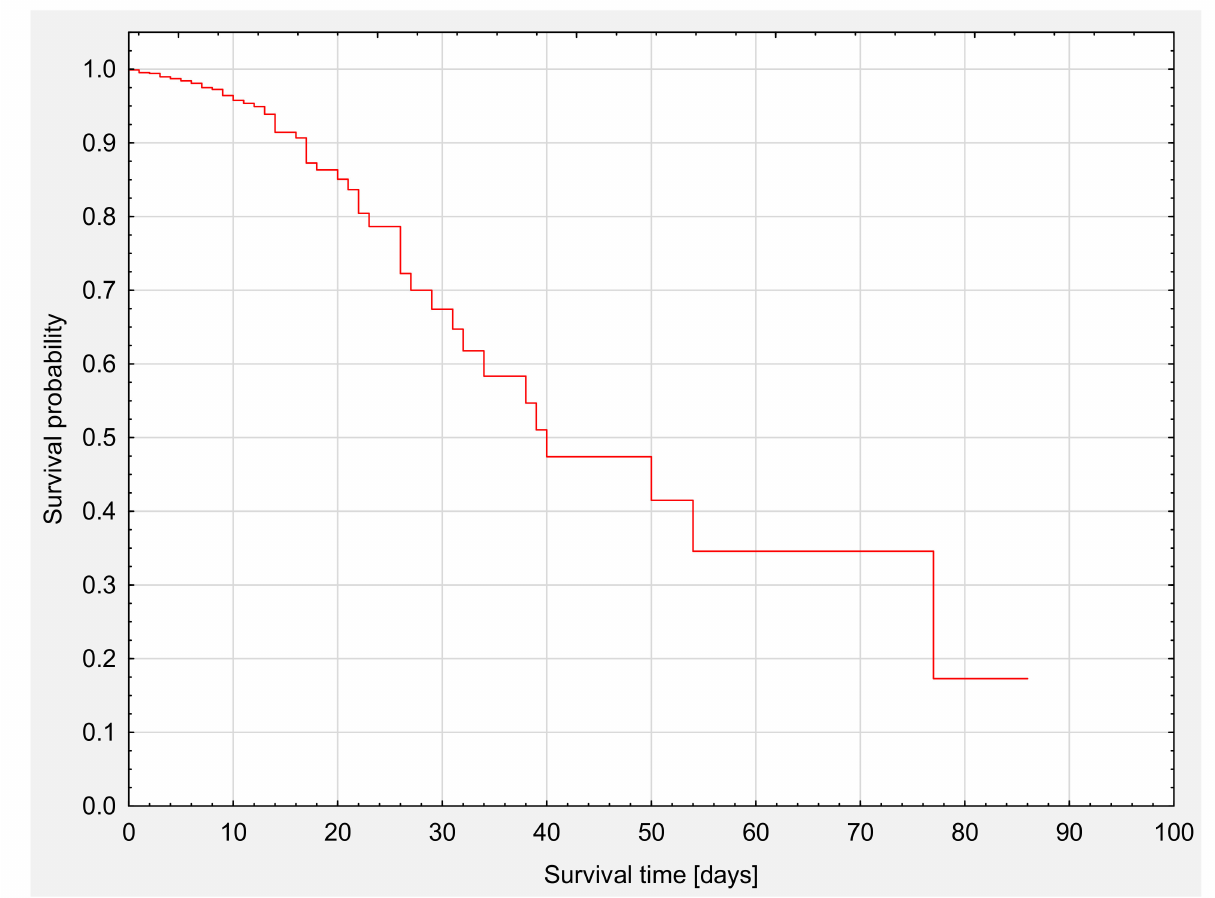
Figure 1. The analysis of survival of the whole